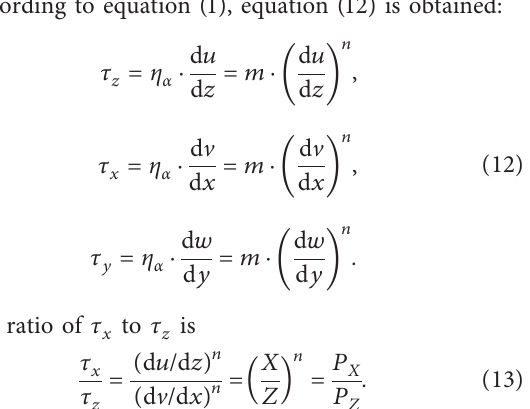
Figure 2: Guide postarrangement of trunk trim panel.